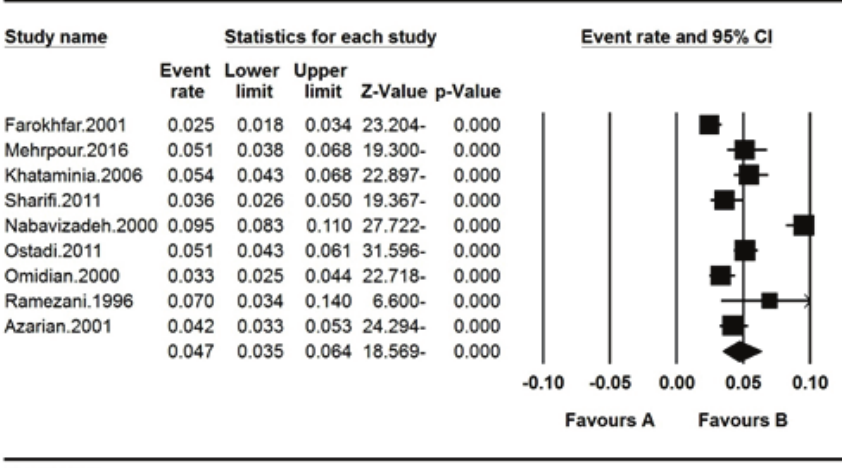
Figure 3. The prevalence of color blindness in Iranian male students.